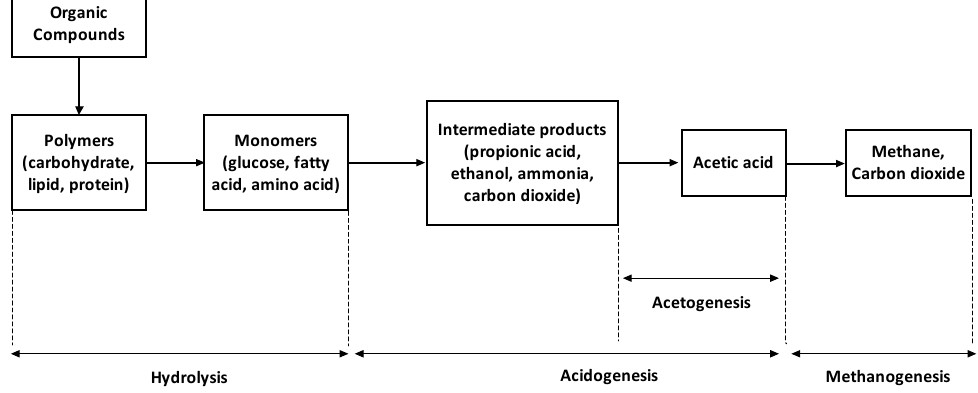
Figure 1. The conversion of organic compounds into biogas.